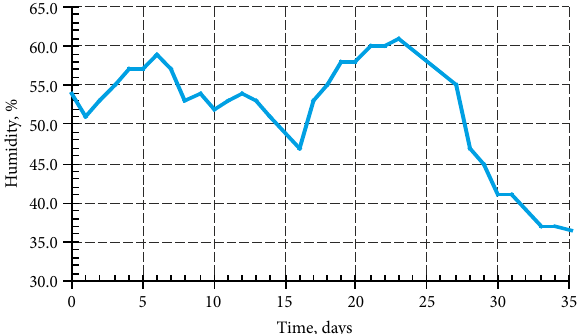
Fig. 4. The schedule of ambient relative humidity change